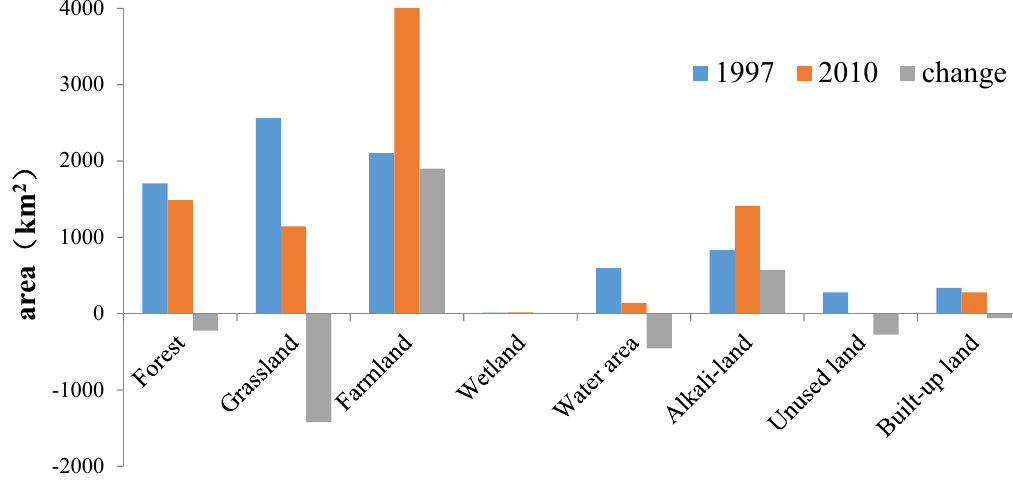
Figure 3. Changes in the land-use area in Tongyu, 1997–2010.